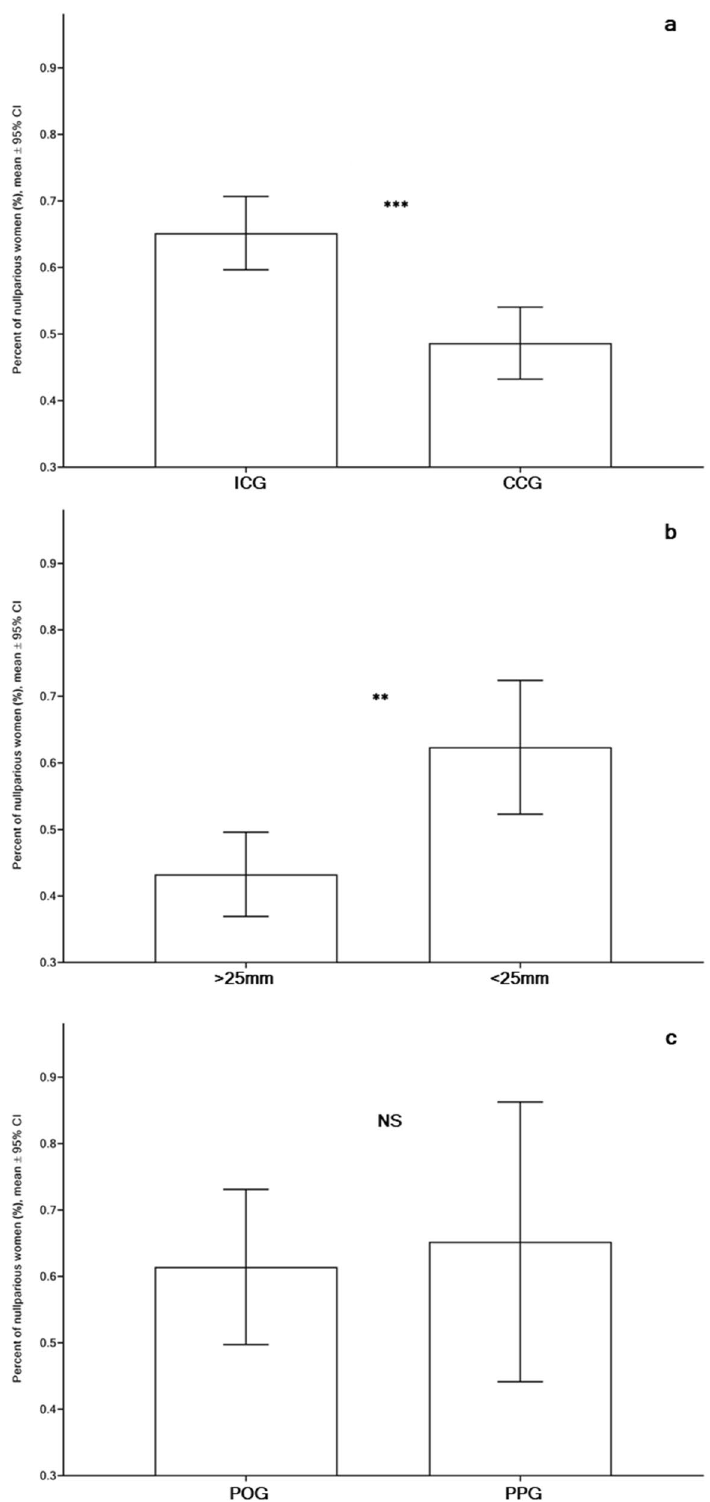
Figure 5. The rate of nulliparous women (unit: %, mean with 95% CI) in asymptomatic women with singleton pregnancies: ( a ) Intact Cervix (ICG) vs. Cervical Conization (CCG), groups; ( b ) Adequate cervical length (CL > 25 mm) vs Short cervix (CL ≤ 25 mm), groups; ( c ) Progesterone-only (POG) vs Progesterone-Pessary (PPG), groups. p-values were achieved using Mann–Whitney two-tailed t-test with Alpha =